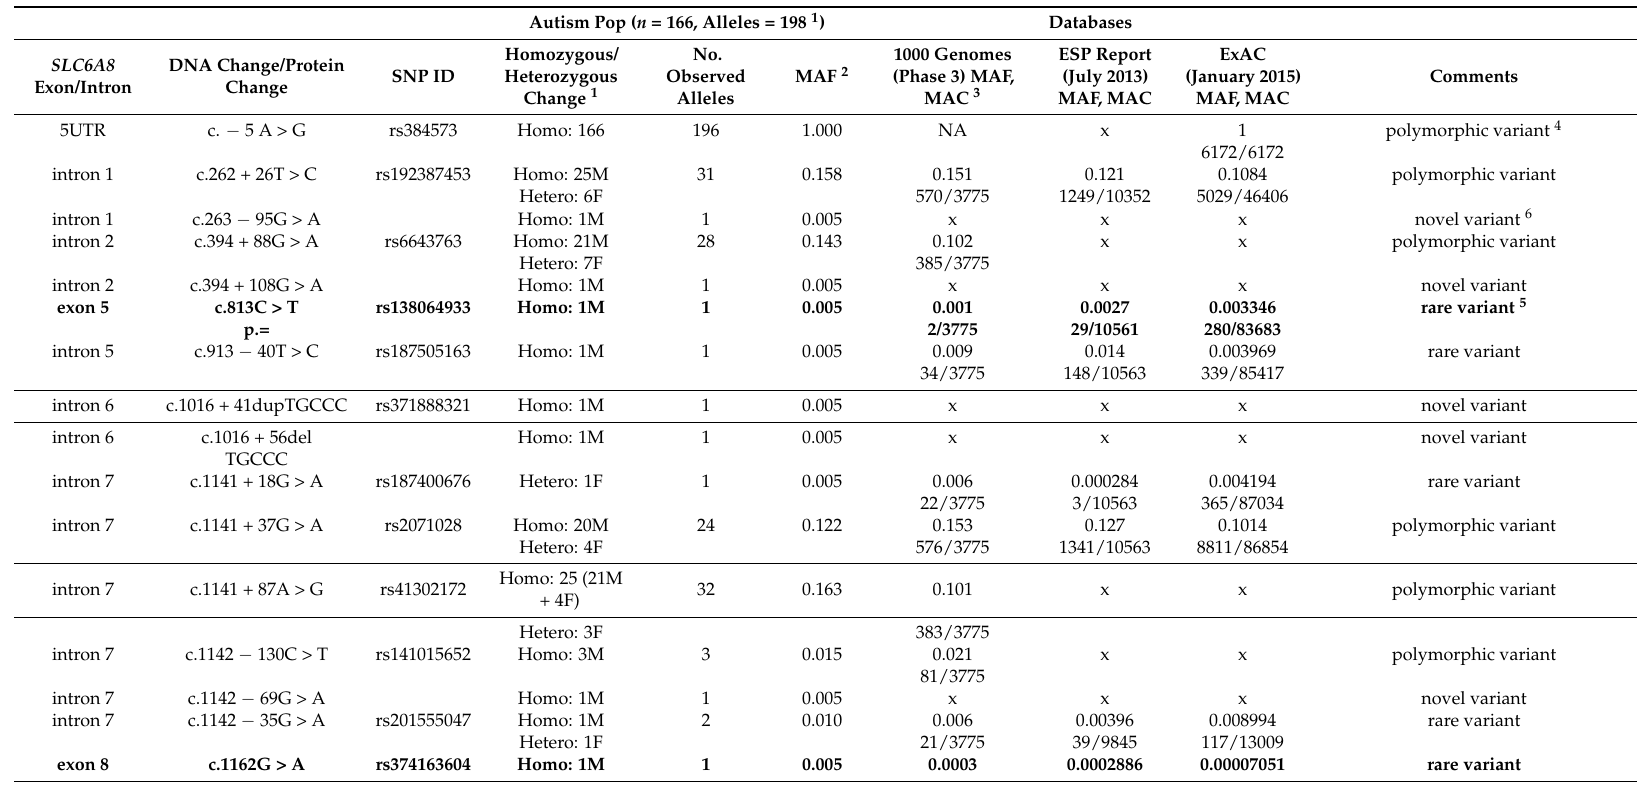
Table 3. Summary of solute carrier family 6 member 8 ( SLC6A8 ) gene sequencing results. Variants identified in the ASD population are noted, and minor allele frequency (MAF) calculated. MAF of variants present in 1000 Genomes, ESP and Exome Aggregation Consortium ExAC databases are shown for comparison. 1 Total number of samples = 166 (134 males, 32 females, 198 alleles); 2 MAF = minor allele frequency; the number of alleles in which variant was found/total number of alleles; 3 MAC = minor allele count; the number of times the minor allele was observed in the sample population of chromosomes; 4 Polymorphic variant: (>0.01 MAF in one database); 5 Rare variant: ≤ 0.01 MAF in at least one published database; and 6 Novel variant: Not present in any published database; coding sequence (exons) are in